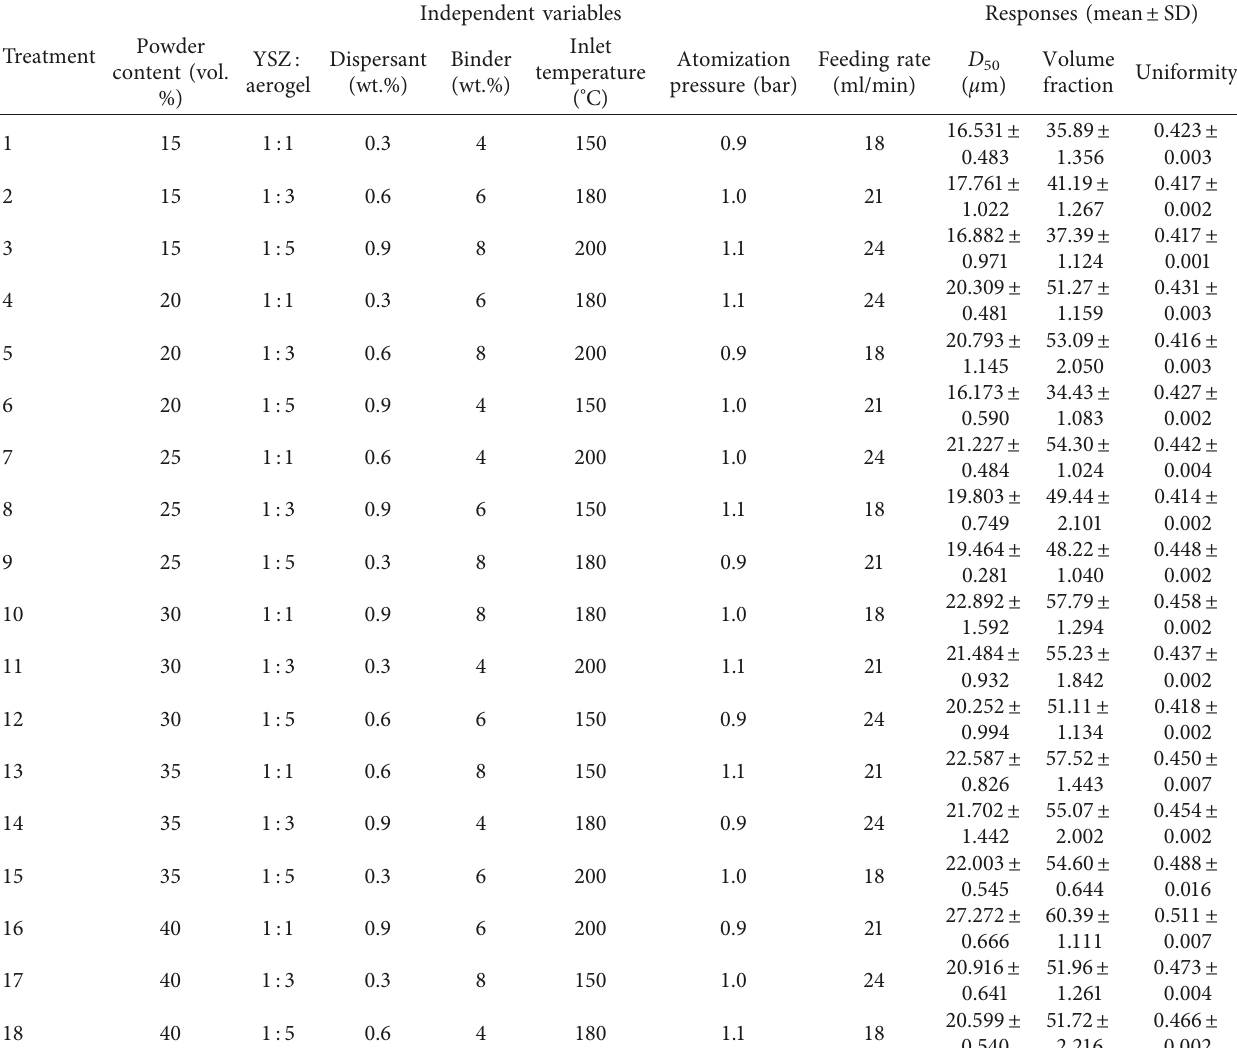
Table 2: Mean responses of the orthogonal experiment for the spray-drying process.